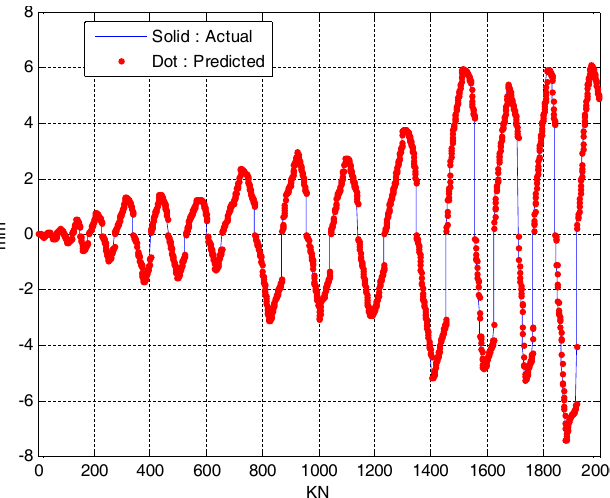
Figure 7. Training for no-fines lightweight concrete wall with the horizontal reinforcement.